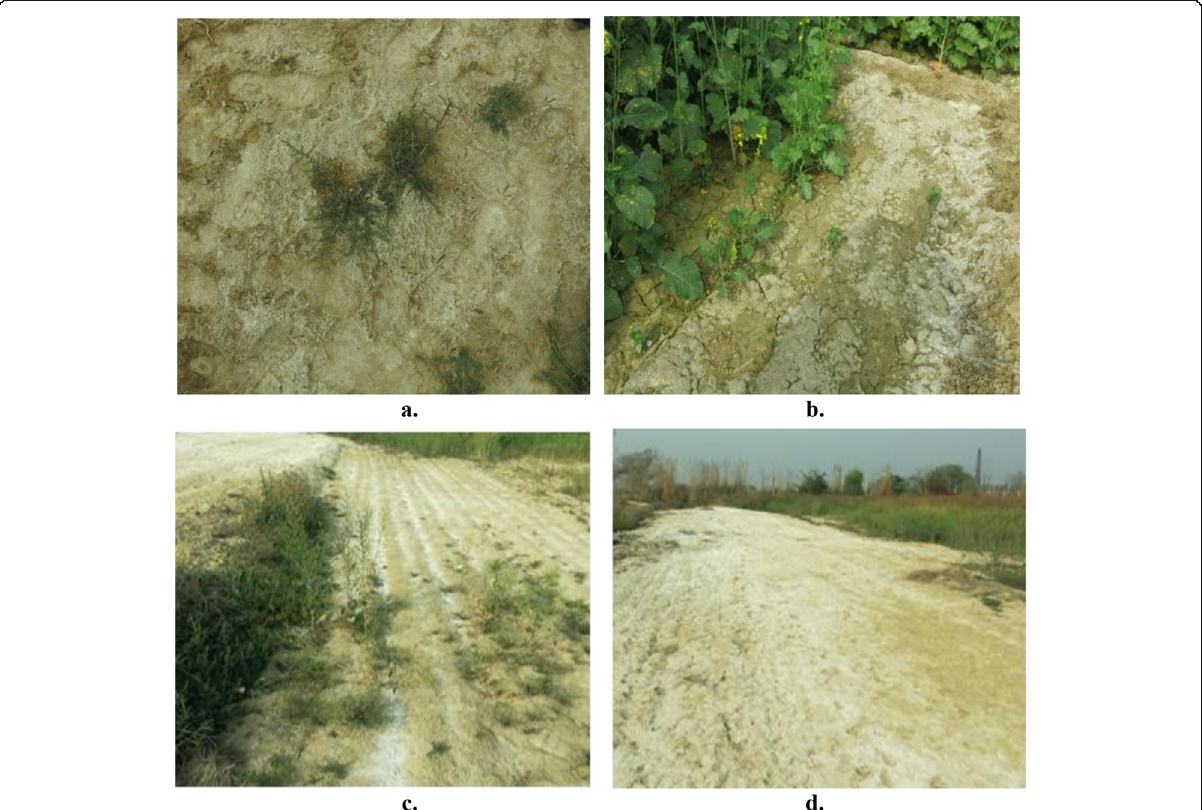
Fig. 1 Saline soil fields of Jhajjar, Haryana, India ( a and b ) and Panipat, Haryana ( c and d